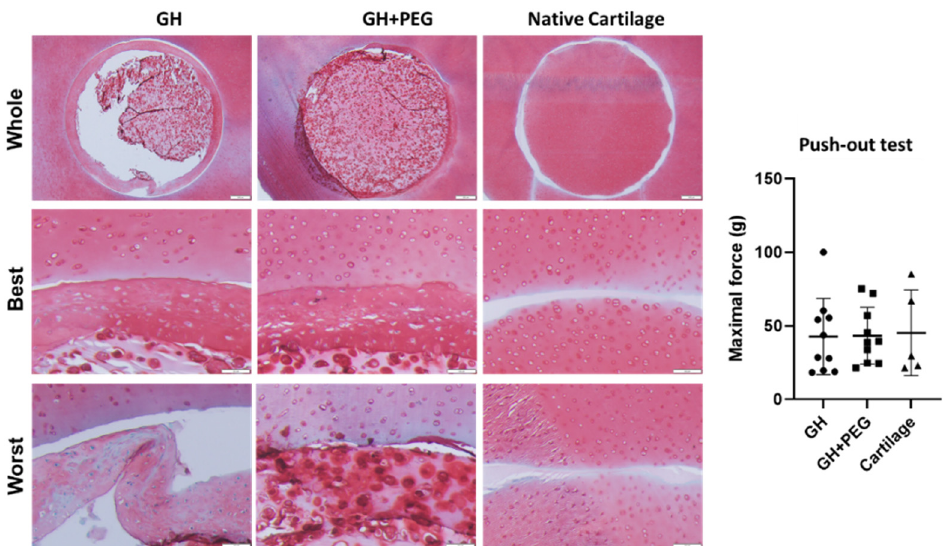
Figure 7. In vitro repair experiment with bovine cartilage explant. H&E staining was used to assess tissue integration. The maximal force during the push-out test was recorded and compared among the three groups. Circles, squares, and triangles represent individual data points in GH, GH+PEG, and cartilage groups, respectively.